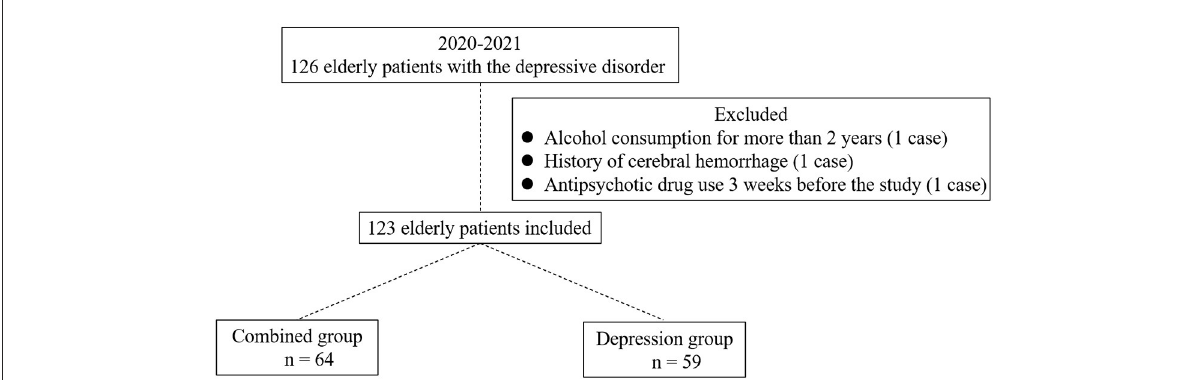
FIGURE1 Enrollment of elderly patients with depressive disorder. A total of 126 elderly patients with depressive disorder were primarily enrolled. One case was excluded for alcohol consumption for more than 2 years, one case was excluded for history of cerebral hemorrhage, and one case was excluded for antipsychotic drug use 3 weeks before the study. A total of 123 patients were finally included, among which 64 patients were divided into the combined group, and the others were divided into the depression